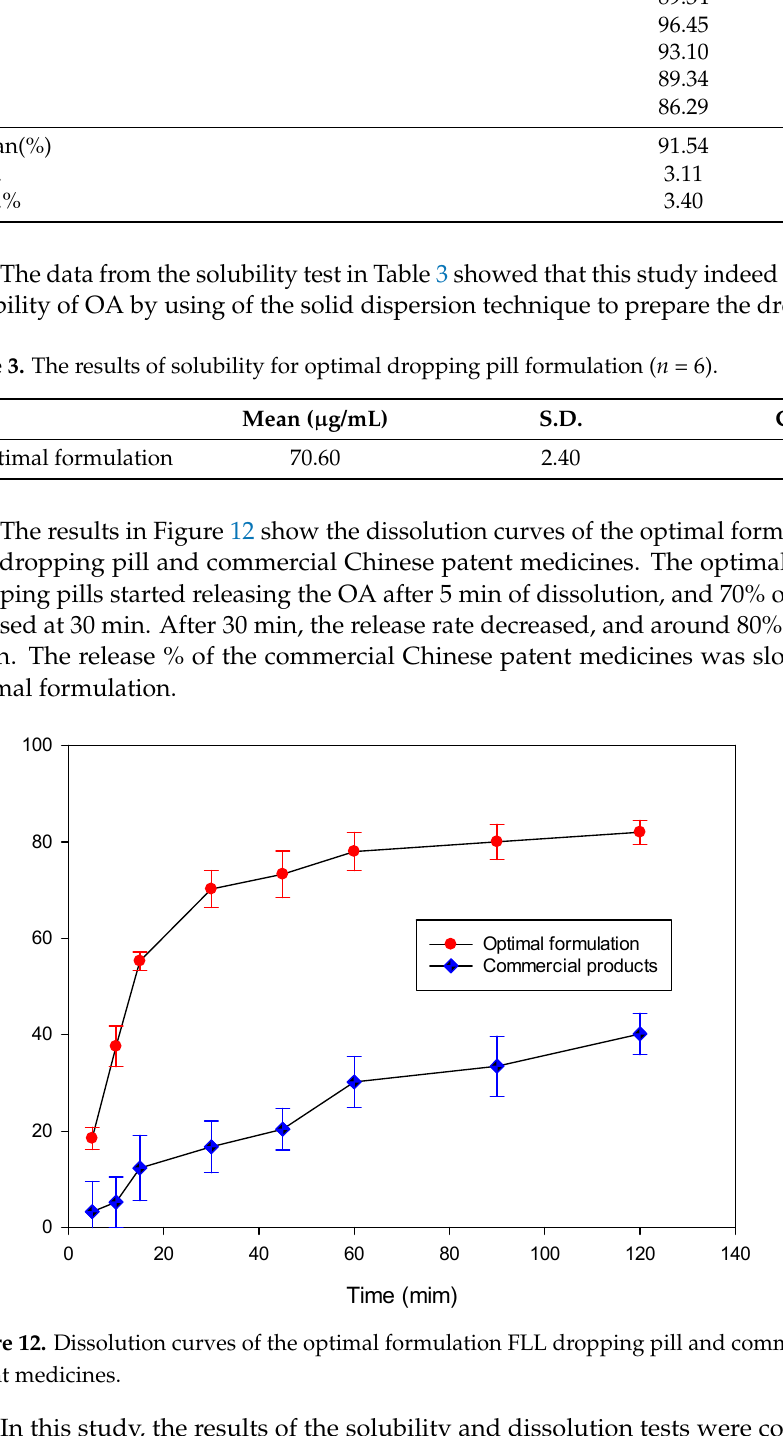
Table 3. The results of solubility for optimal dropping pill formulation ( n = 6) .